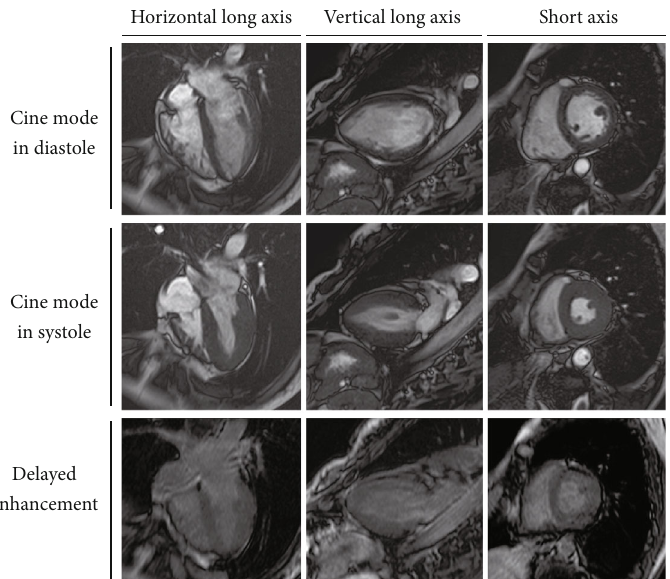
Figure 5: Cardiac magnetic resonance imaging showing no fi ndings of morphological abnormalities or delayed